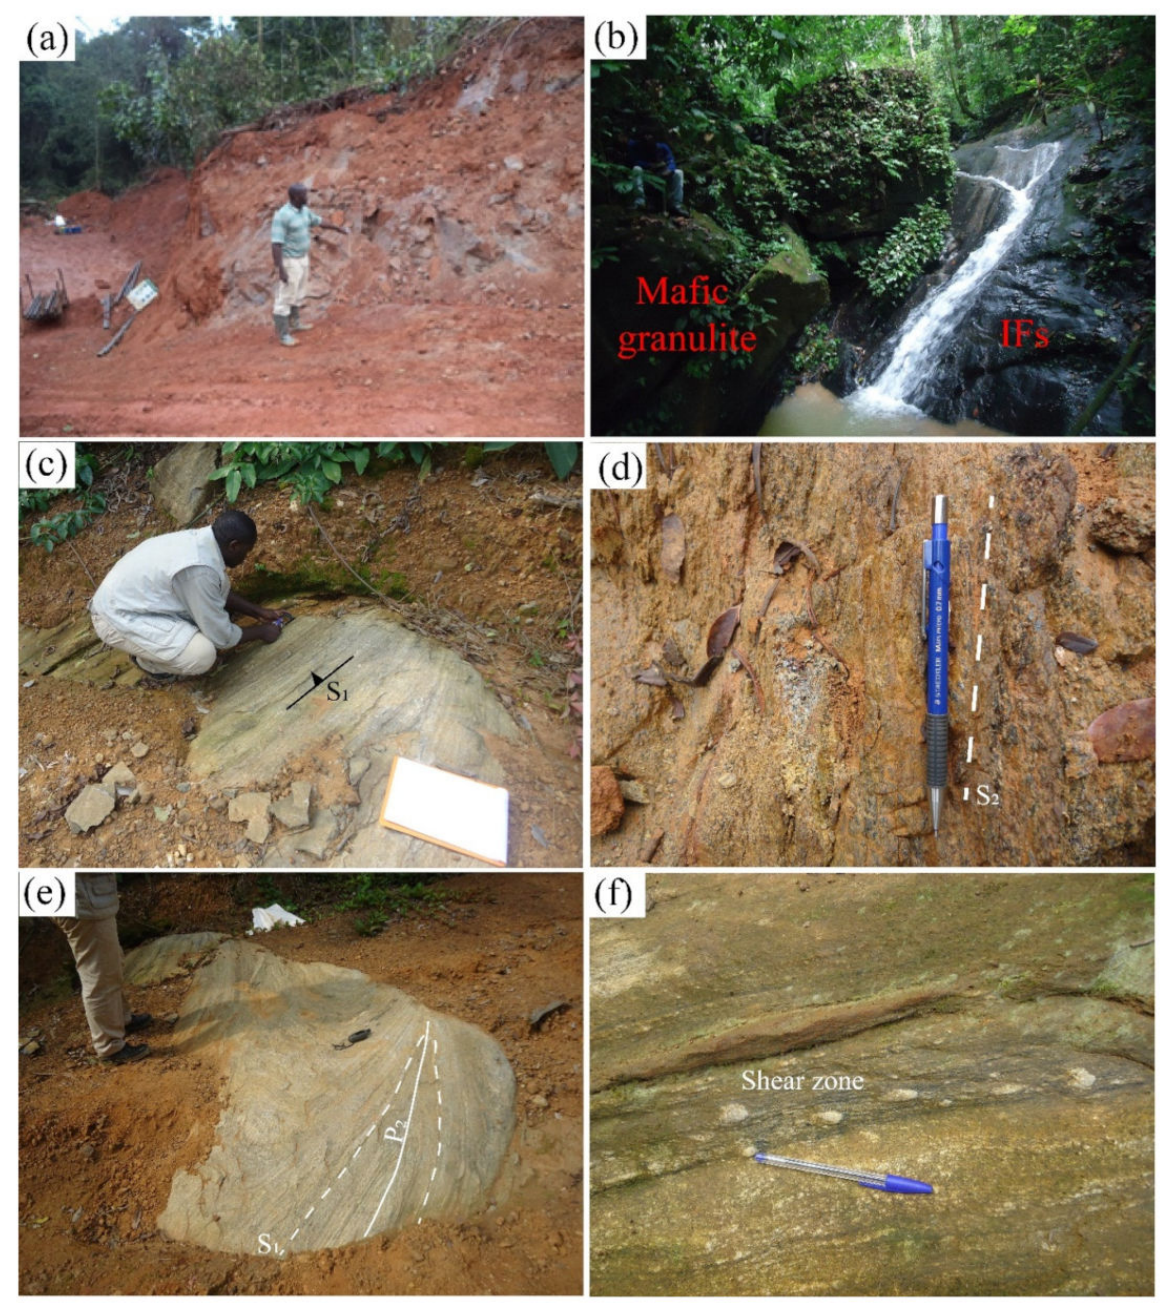
Figure 3. Outcrop views and deformation features: sheared banded iron formation (SBIF) outcropping as ( a ) road cuttings; ( b ) river bed generally associated with mafic granulite; ( c ) S 1 foliation in Biotite gneiss; ( d ) S 2 foliation in SBIF; ( e ) P 2 fold in biotite gneiss; ( f ) Shear zone in biotite